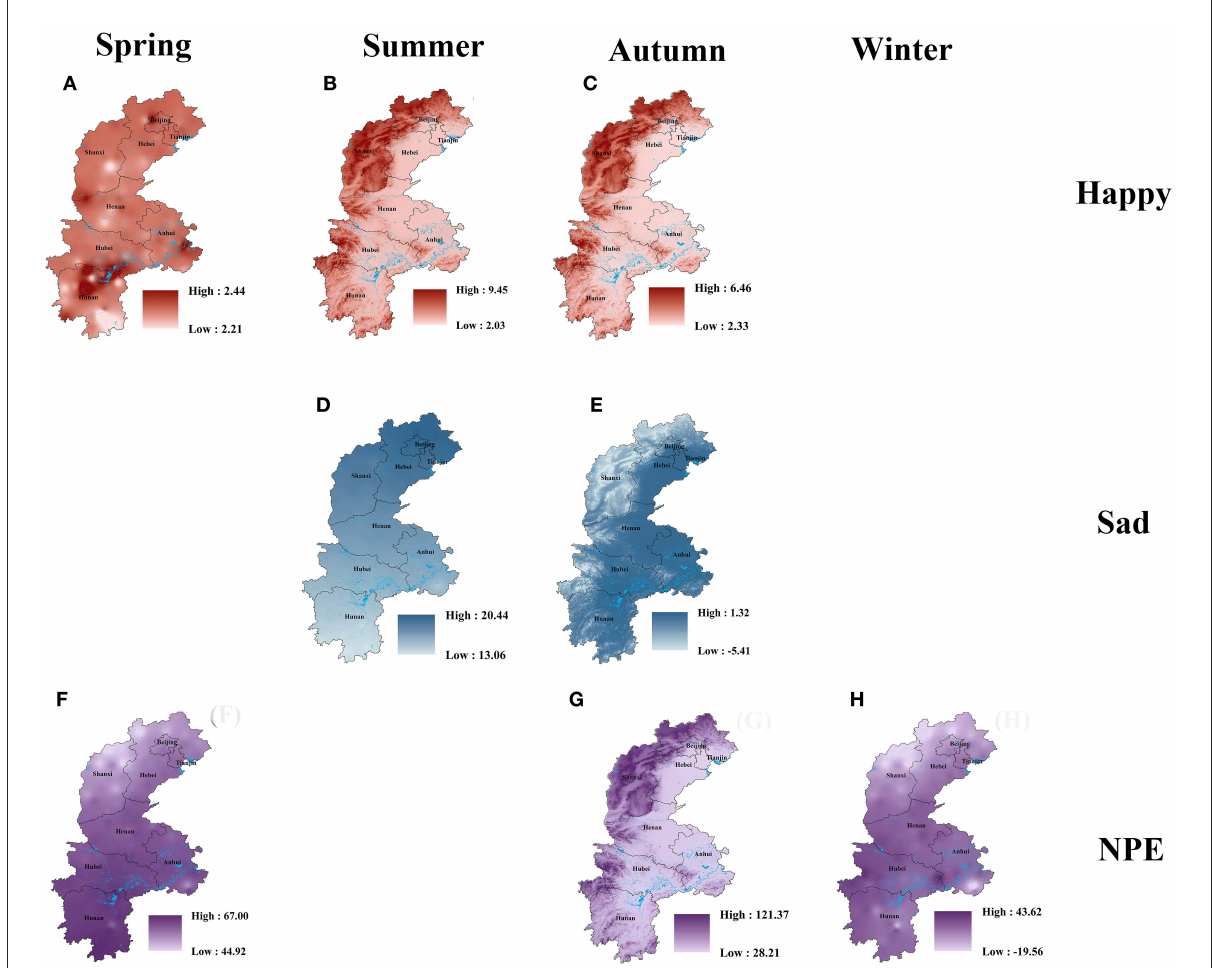
FIGURE7 Seasonal distributions of predicted facial expression scores for happy and sad emotions and net positive emotion index (NPE) from potential experiences of visitors in blue spaces in regions of Central China. Regions in the blue color mark blue spaces that have regressed characteristics in landscape and microclimate from selected urban wetland parks. Regional distributions are interpolated by regression results adapted from Table 4. (A–C) Predicted happy scores in spring, summer, and autumn, respectively; (D,E) Predicted sad scores in summer and autumn, respectively; (F–H) Predicted NPE in spring, autumn, and winter,